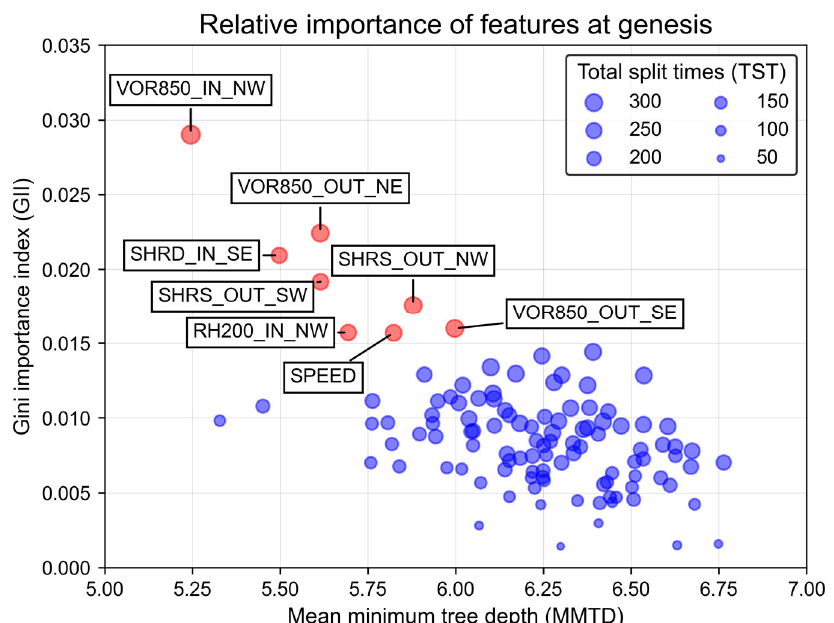
Figure 6. Scatter plot of features at genesis showing their relative importance to LMI in step 1. x- and y-axes refer to weighted mean minimum tree depth (MMTD) of all base estimators and Gini importance index (GII), respectively, with size of points controlled by total split time (TST) in all trees of the ensemble model. Red points are features with the greatest importance judged by the three criteria, and blue scatters are ordinary features. Text after feature names in rectangles denote sectors indicated in Figure 1.